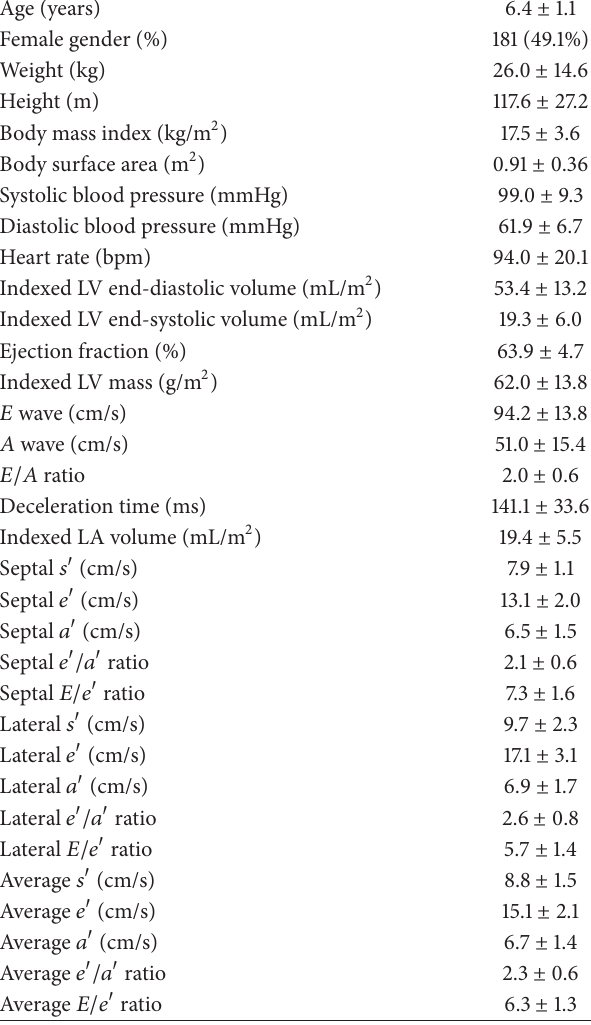
Table 1: Main clinical and echocardiographic characteristics of the study